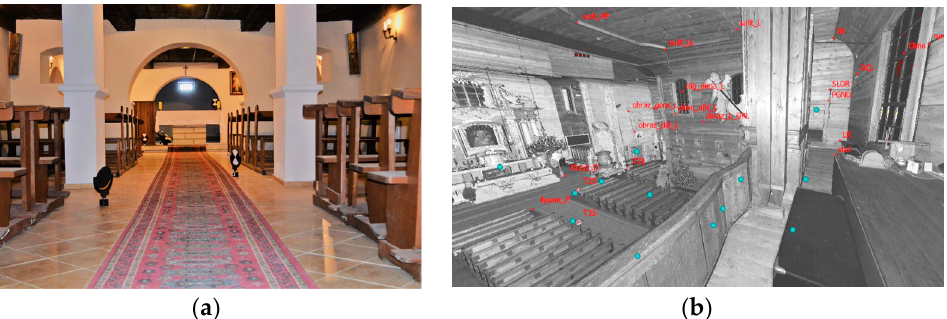
Figure 5. Measurement targets in the underground chapel ( a ) and the view of the scanning data in the reflectance intensity of the laser beam—one of the scanner positions inside the church ( b ).